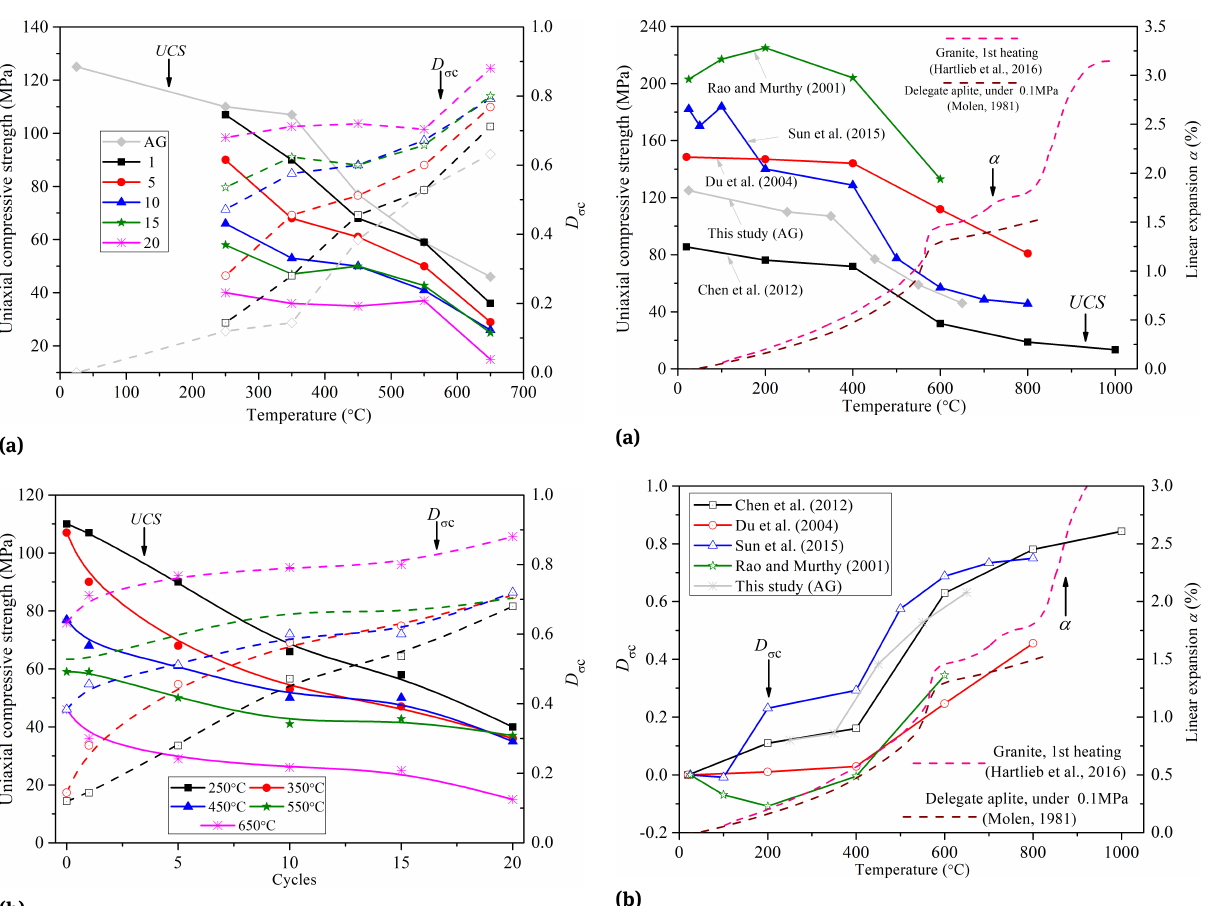
Figure 3: (a) UCS (solid line) and linear expansion, α , (dotted line), and (b) thermal damage index, D σc , (solid line) and α (dotted line), of granite versus elevated